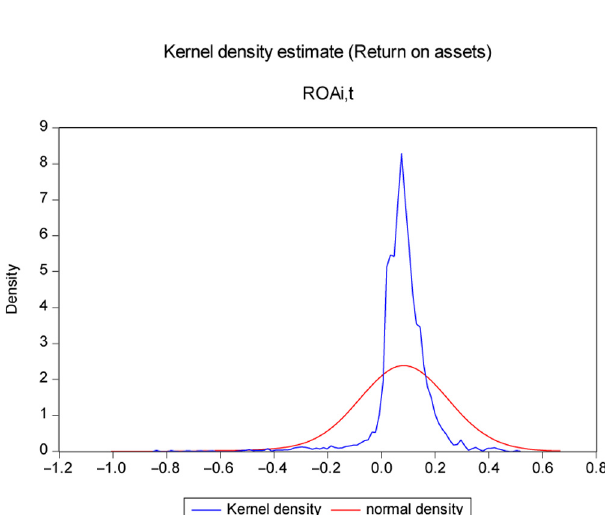
Figure 7. Non-normality of overcon fi dence (both sectors combined: all companies)